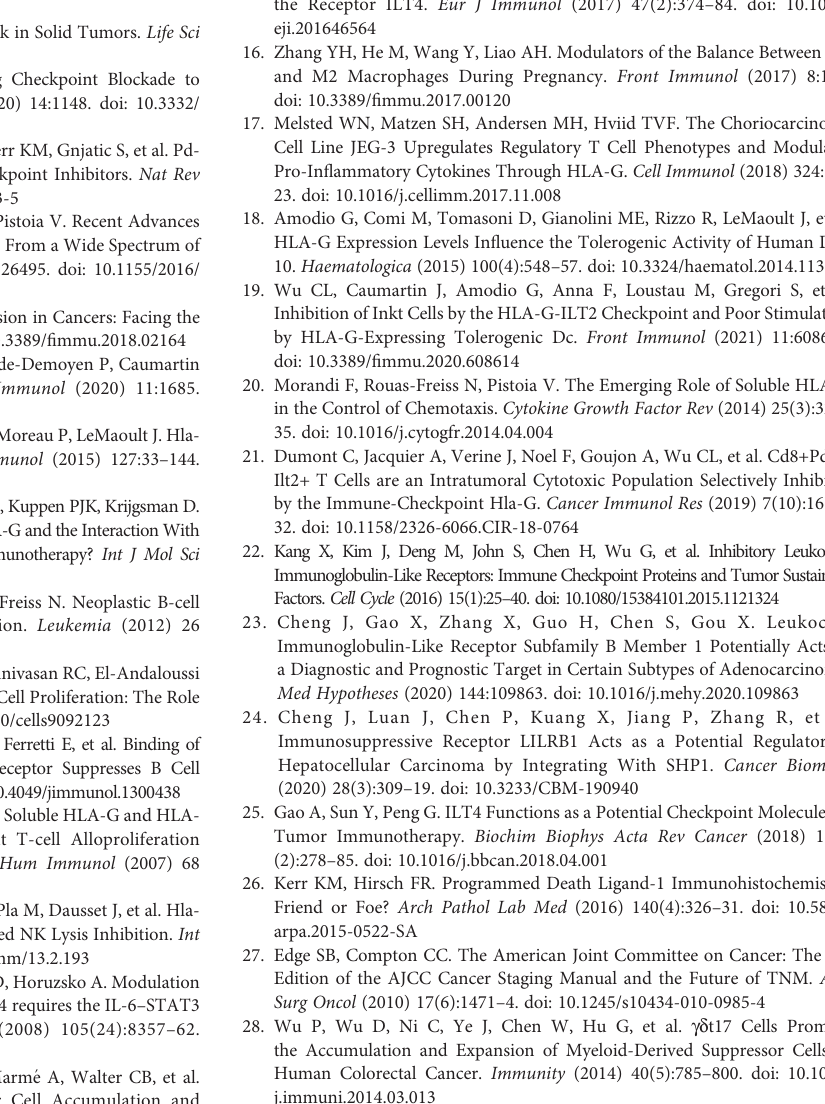
Supplementary Figure 1 | | Bivariate correlation analysis between the expression of HLA-G, ILT-2, ILT-4, and PD-L1 performed using Pearson test. Supplementary Figure 2 | Flowchart of the study